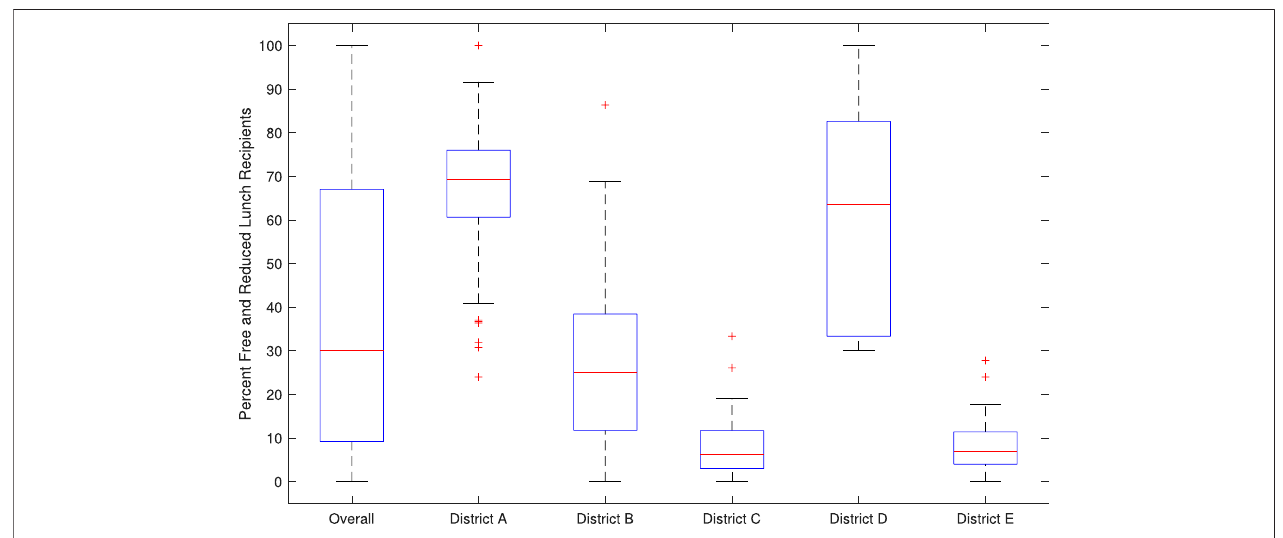
FIGURE 1 | Box plot of the percent of students in the measured classrooms ( n (cid:1) 216) receiving free or reduced-price lunches, shown by district.